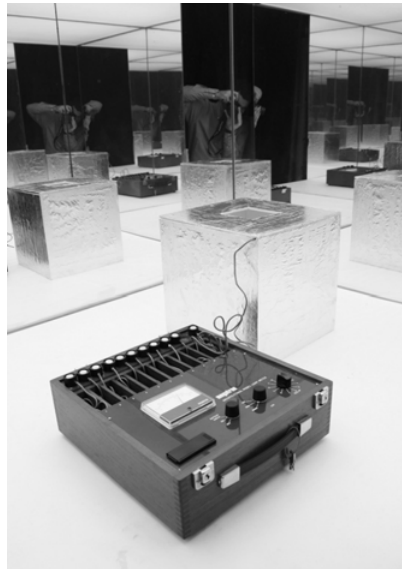
Figure 7. Parallelepiped artificial sky used in the trial.